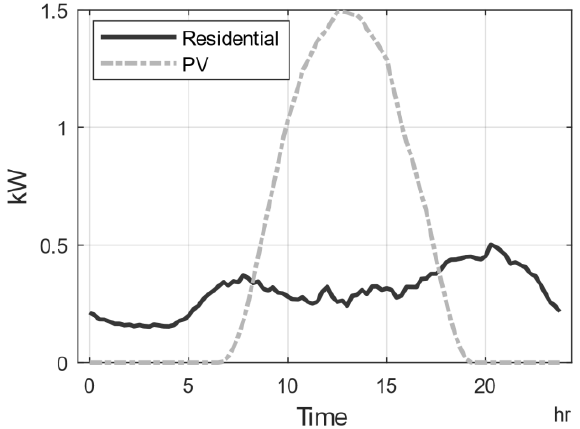
Figure 2. Average profile for residential consumers and PV generation.